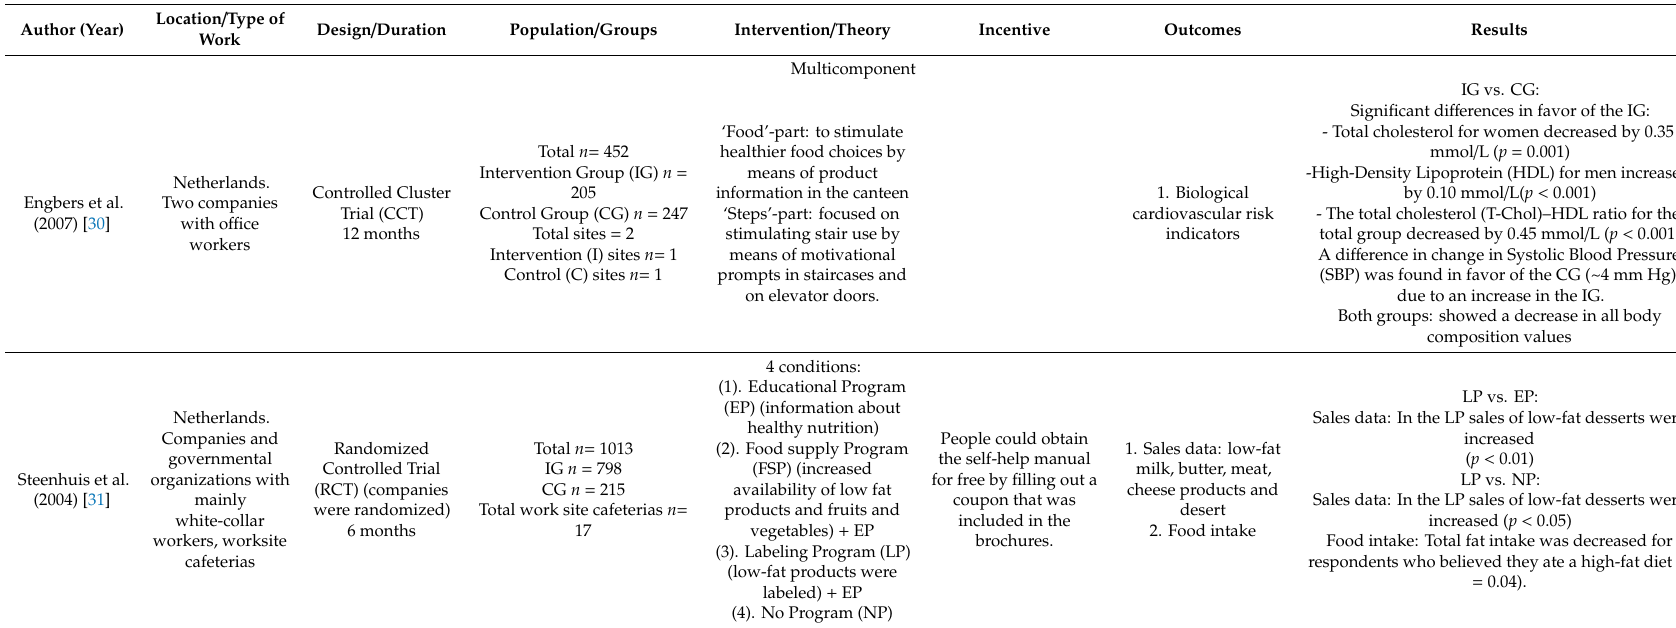
Table 4. Summary of the studies focusing on multicomponent interventions listed by author and year, the study design, duration, sample size, intervention type, intervention, incentive, outcome measures, and main